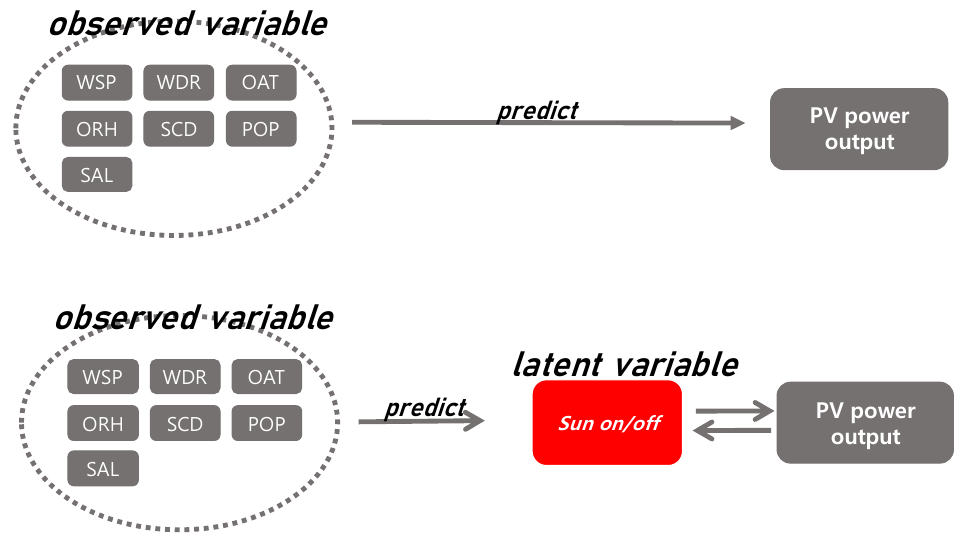
Figure 1. ( top ): Conventional prediction methods; ( bottom ): proposed method.